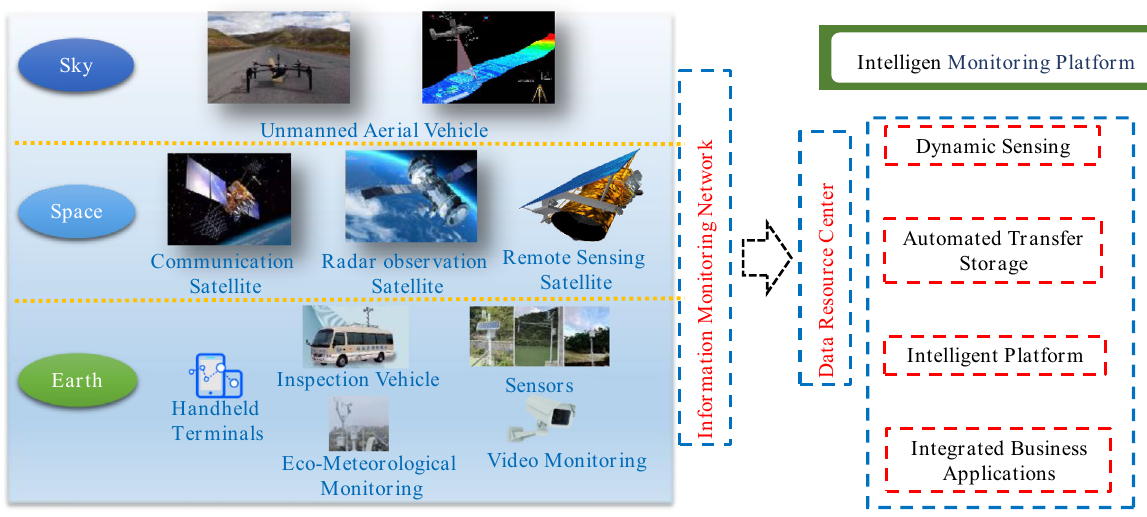
Figure 11. Framework of the intelligent monitoring system for soil and water conservation 43